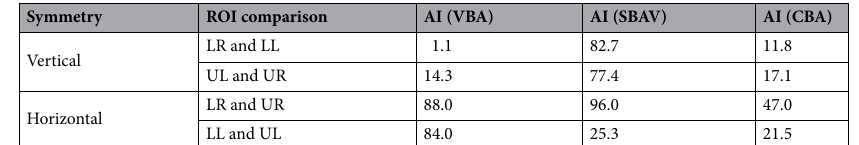
Table 4. Vertical and horizontal asymmetry indices (AIs). To assess the impact of the three alignment techniques on horizontal and vertical symmetry of our group-level ROIs, we computed a ROI size AI between each pair of ROIs. AIs revealed greater vertical symmetry of the upper and lower hemifield ROIs for VBA and CBA compared to SBAV. LR lower right visual quadrant, LL lower left visual quadrant, UL upper left visual quadrant, UR upper right visual quadrant.